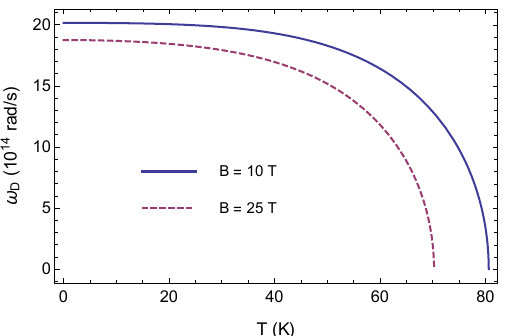
Figure 4. Temperature dependence of frequency ω